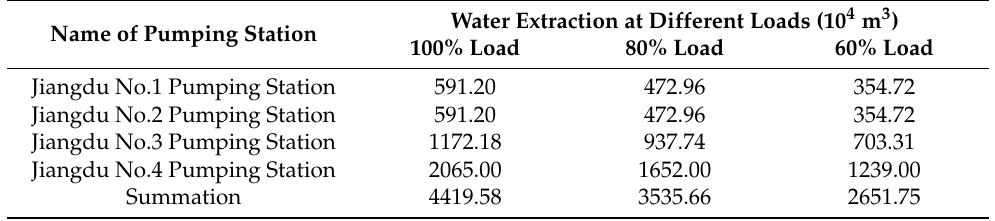
Table 3. Target water extraction of each pumping station under different kinds of water extraction loads with average daily head of 7.8 m.